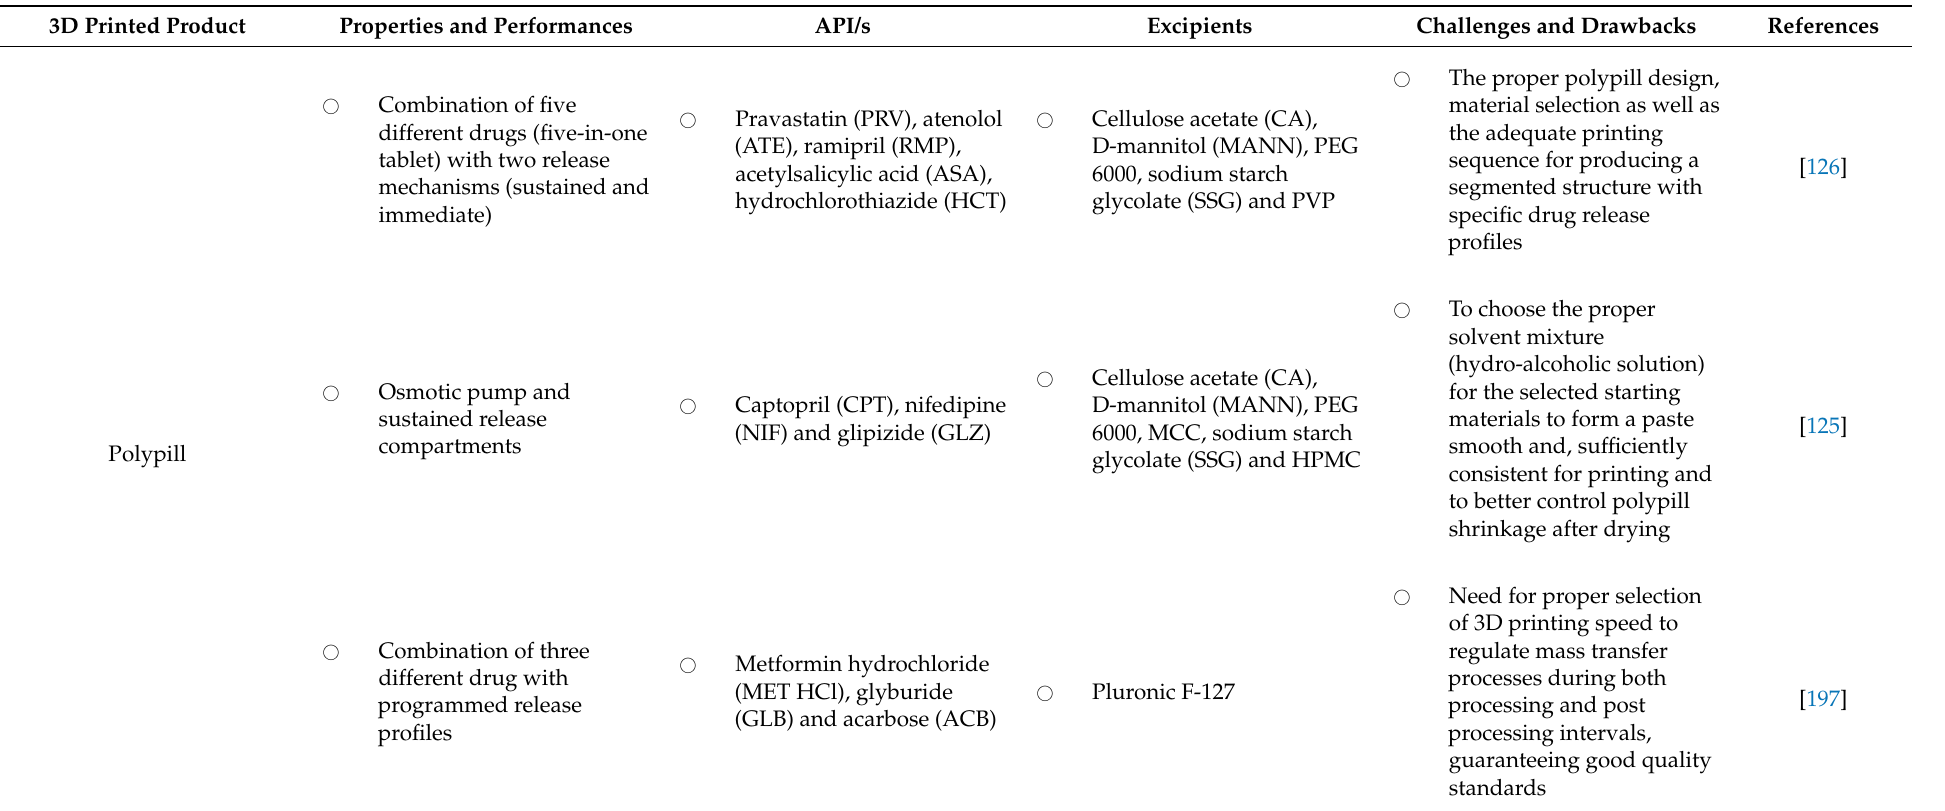
Table 3. Literature examples on dosage forms and medical devices produced via SSE 3DP. In evidence for each product—performances; —starting materials (polymers/excipients and APIs); —challenges and